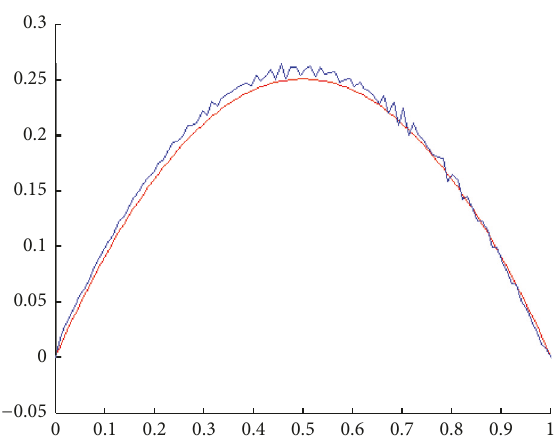
Figure 14: Initial temperature in err = 5% ‖𝜓 exact 0 ‖ 2 case. The recon- structed initial condition is not far from the true state.